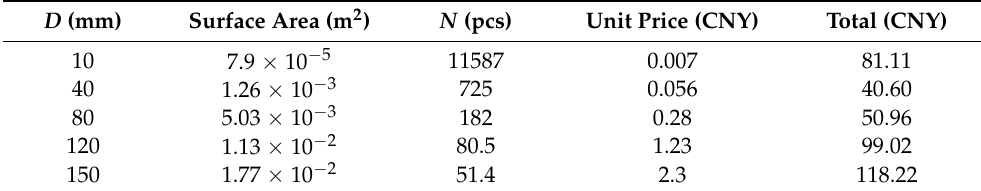
Table 10. Preliminary calculations of floating ball